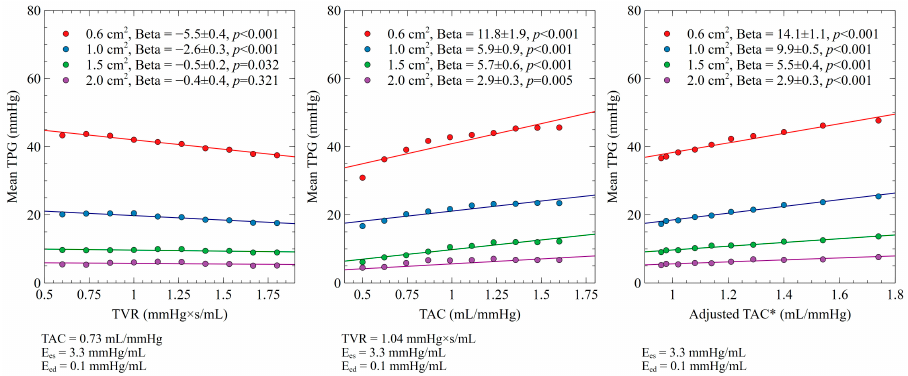
Figure 4. Impact of TVR and TAC on mean TPG for different levels of aortic stenosis. Adjusted TAC*: coupled TAC according to its hyperbolic relation with TVR [61]. Table 1. Relative contribution of each determinant on TPG for different levels of aortic valve stenosis. Beta coefficients (Beta) are expressed in pressure (mmHg) for every 10% increase of each determi ‐ nant from the baseline (lowest) value.